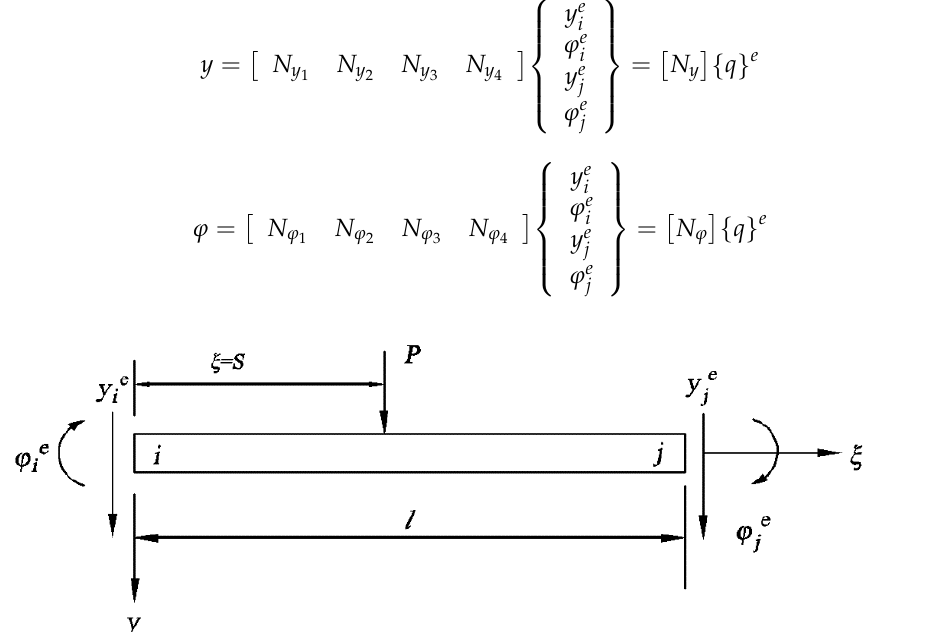
Figure 2. Different truncated series solutions of the beam with b = 0.03 and c = 0.11.